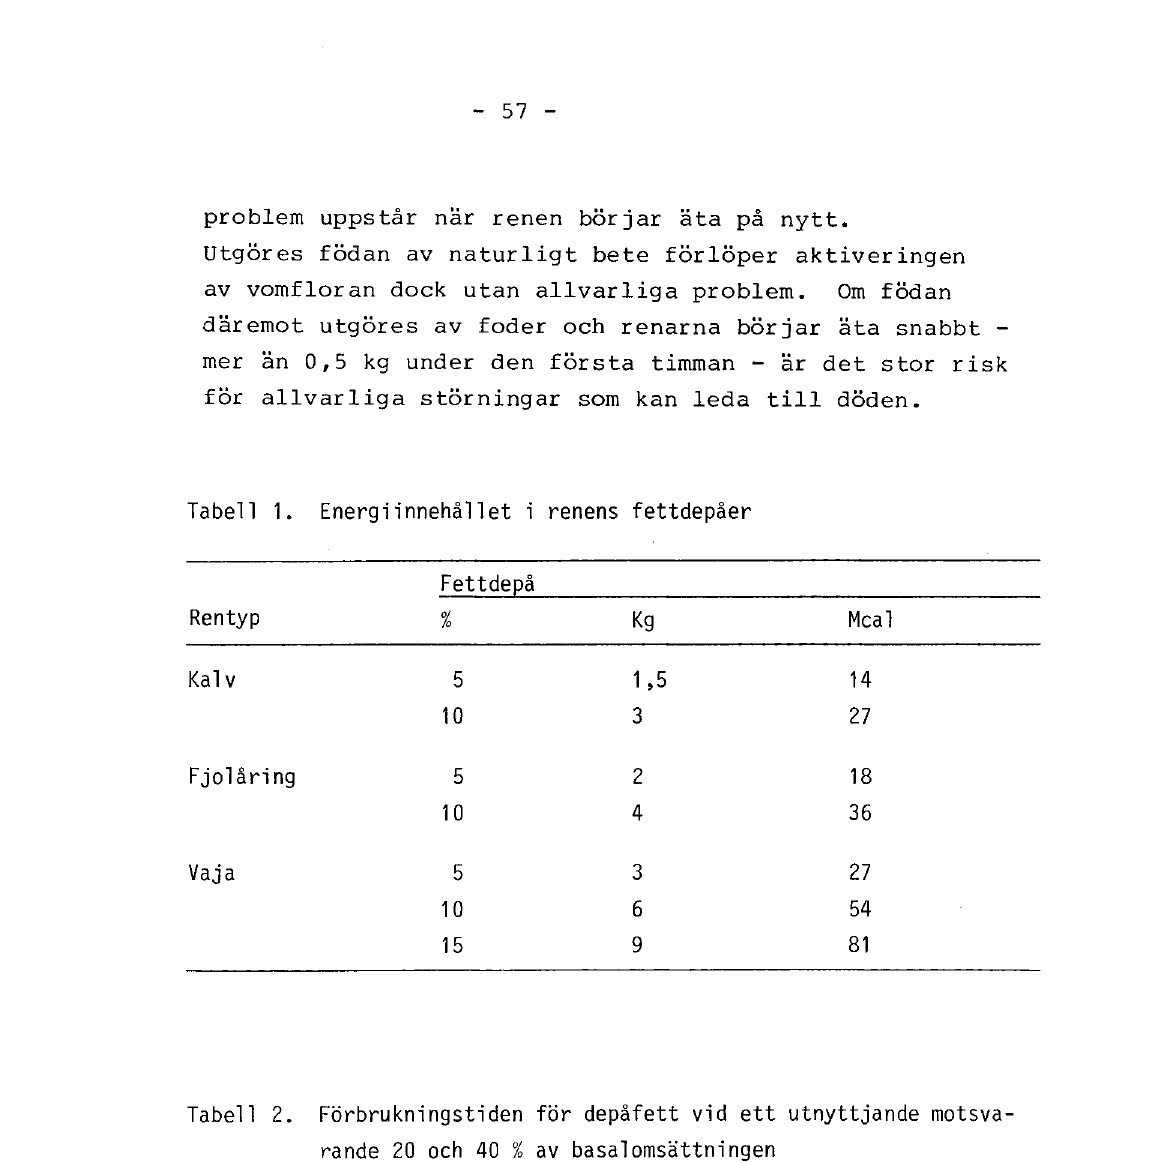
Tabell 2. Fbrbrukningstiden for depåfett vid ett utnyttjande